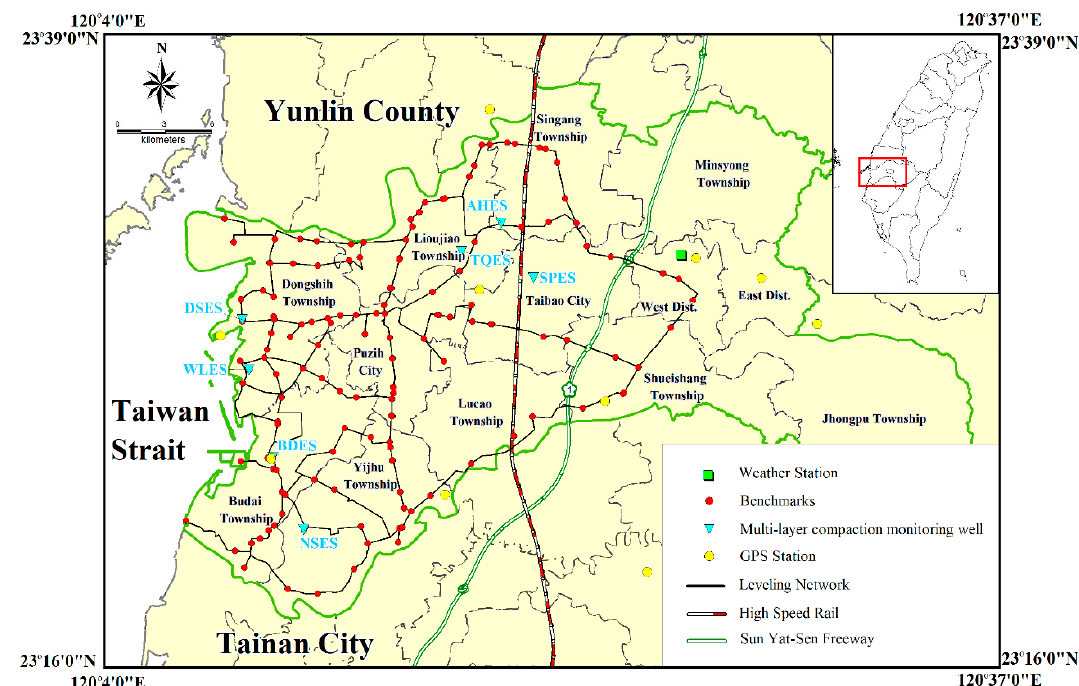
Figure 3. Distributions of leveling benchmarks, multi-layer compaction monitoring wells and GPS stations in Chiayi.